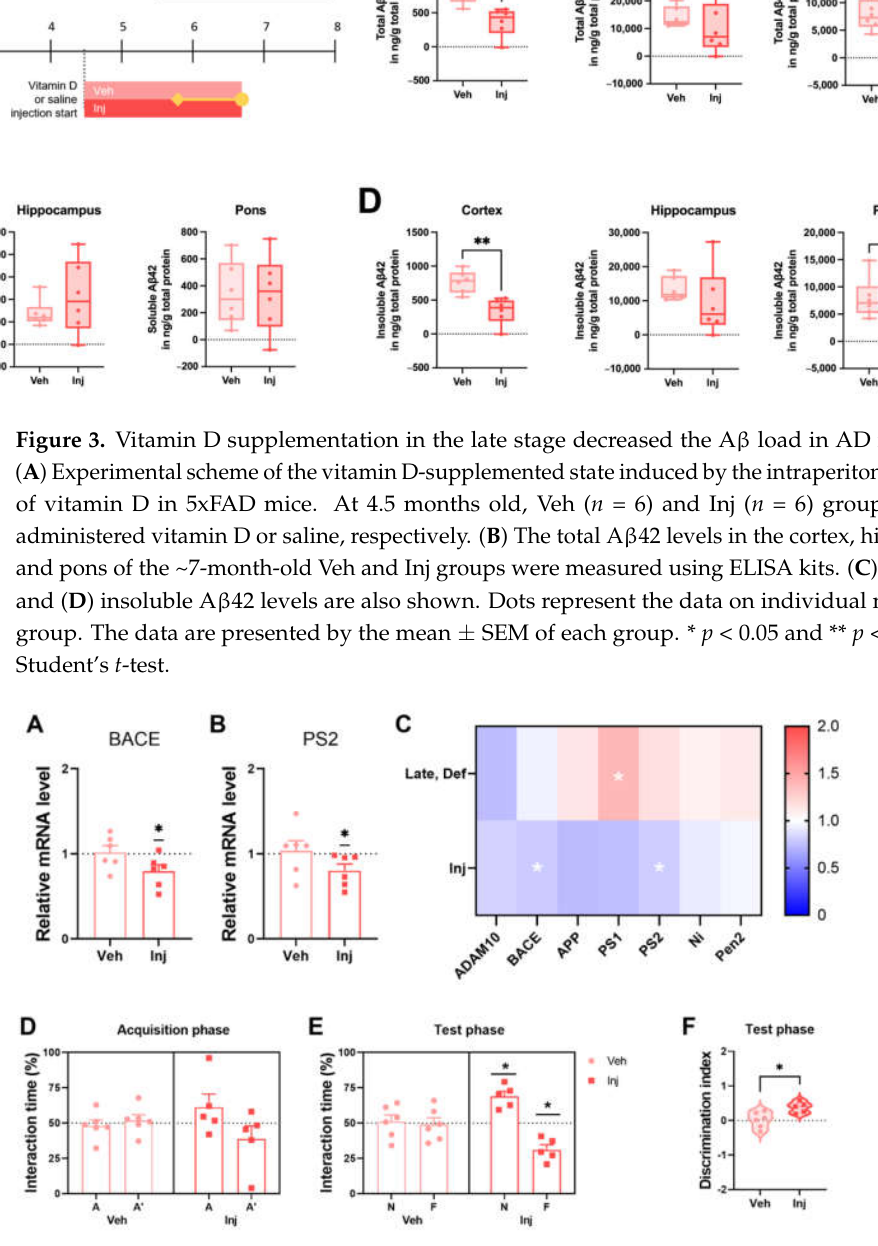
Figure 4. Vitamin D supplementation resulted in less A β processing and improved memory in AD model mice. ( A , B ) The results of the qRT-PCR analysis of mRNA expression of ( A ) BACE and ( B ) PS2 in the Veh ( n = 6) and Inj ( n = 6) groups are exhibited. ( C ) A heatmap of the qRT-PCR results of A β processing-related gene expression is illustrated to compare the Veh ( n = 6) and Inj ( n = 6) groups. The interaction time spent in each location of the Veh ( n = 6) and Inj ( n = 5) groups in ( D ) the acquisition phase and ( E ) test phase are illustrated. ( F ) The discrimination indexes of the Veh and Inj groups are shown. Dots represent the data of individual mice in each group. Interaction times are expressed for each location as a percentage of the total exploration time and were tested for the statistical difference against a 50% theoretical mean (one-sample t -test). The data are presented by the mean ± SEM of each group. * p < 0.05 by the Student’s t -test.